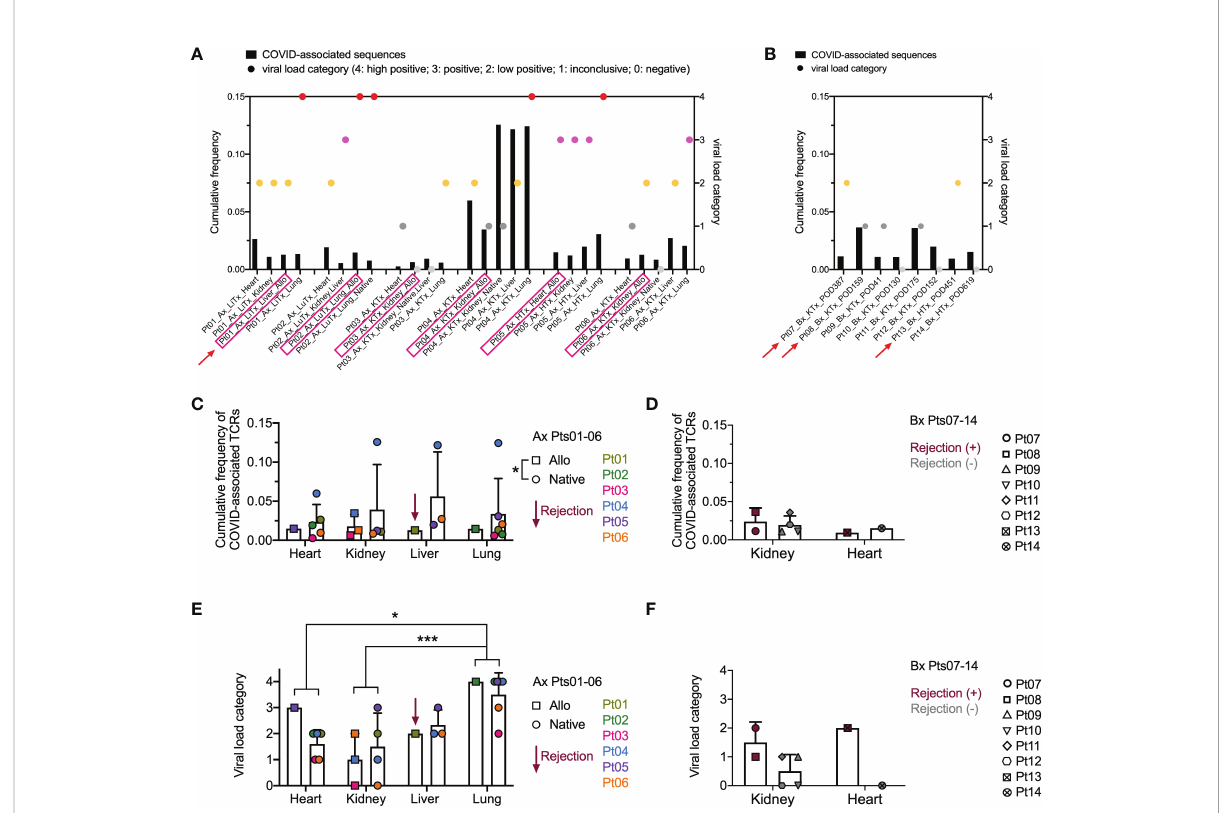
FIGURE 5 Overview of COVID-associated TCR clonal distribution and association with viral loads across individual patients and tissue types. (A, B) Left Y axis: cumulative frequency of COVID-associated TCRs de fi ned by CDR3 + v + j sequence overlap at the amino acid level with the ImmunoSEQ T-MAP COVID database. Right Y axis: semi-quanti fi ed viral load categories (4: high positive; 3: positive; 2: low positive; 1: inconclusive; 0: negative). Autopsy (Ax) and biopsy (Bx) specimens are shown in A and B, respectively, with allograft samples highlighted with pink rectangles on the x axis. Red arrows indicate graft rejection determined by histology. (C) Cumulative frequency of COVID-associated TCRs in different organs subgrouped by allografts (squares) and native tissues (circles) for autopsy specimens of Pts01-06. Pt01 liver graft was diagnosed as rejection. (D) Cumulative frequency of COVID-associated TCRs in kidney or heart biopsies of Pts07-14 subgrouped by rejection status. (E) Viral load categories of different organs subgrouped by allografts (squares) and native tissues (circles) for autopsy specimens of Pts01-06. (F) Viral load categories of kidney or heart biopsies of Pts07-14 subgrouped by rejection status. Statistical signi fi cance was determined by Two-way ANOVA, followed by Tukey ’ s multiple comparisons test for panel C-F. *p<0.05,